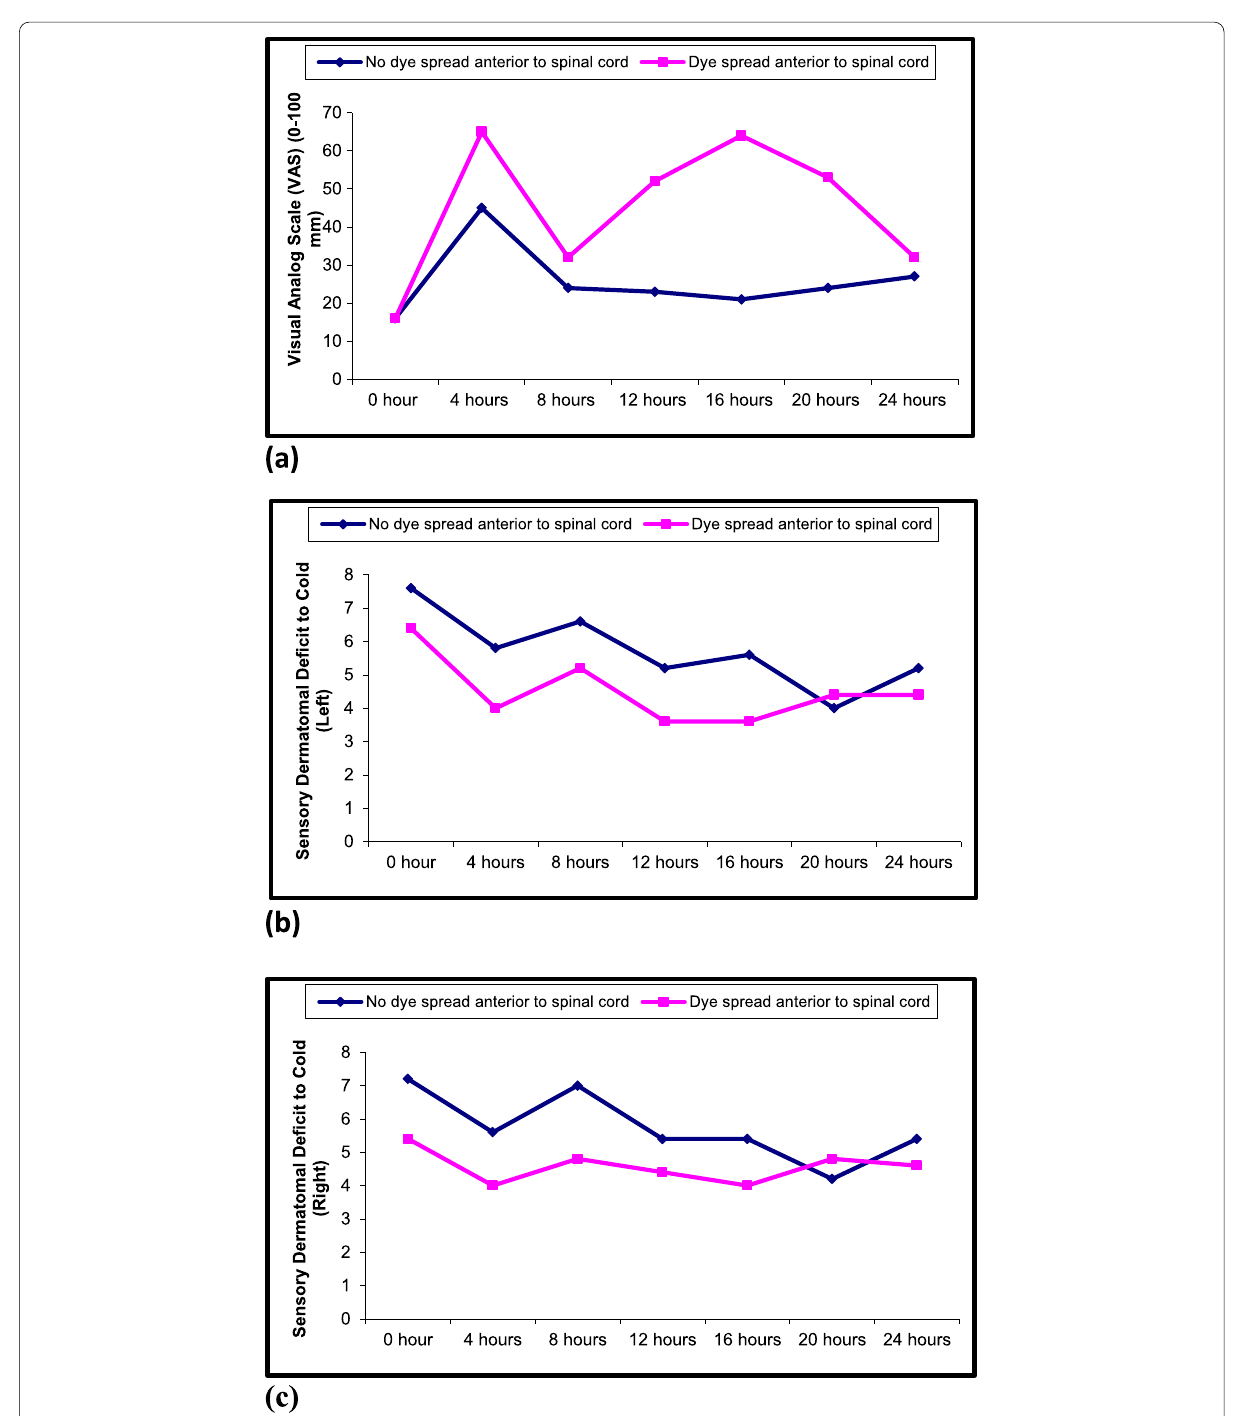
Fig. 4 a Lower VAS scores with NO anterior dye spill. b Wider deficit on the left side with NO anterior dye spread. c Wider dermatomal block on the right side with NO anterior dye